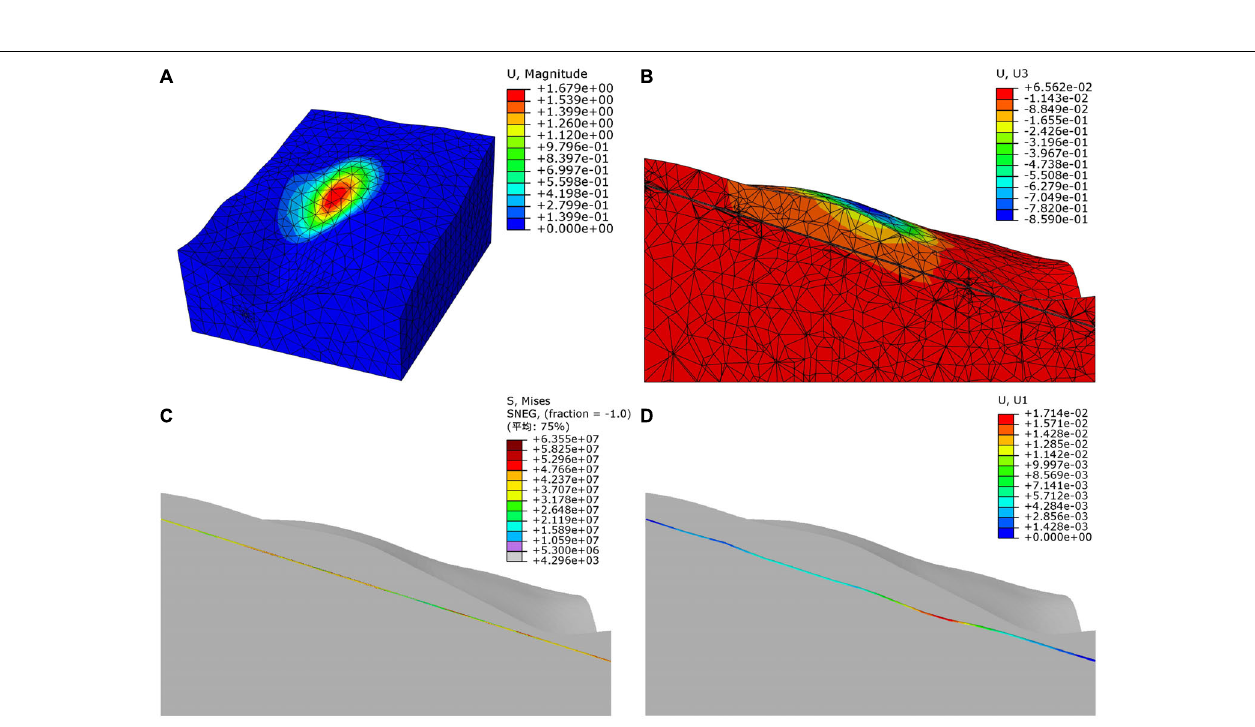
FIGURE 13 | Slope displacement, pipeline Mises’s stress, and pipeline displacement in the limit equilibrium state. (A) Slope displacement, (B) Slope vertical displacement along the pipe section, (C) Pipe Mises stress, and (D) Along an unstable slope deformation of the pipe in the direction of movement ( x direction).